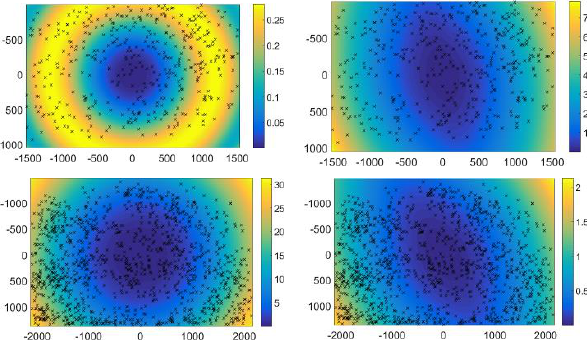
Figure 5. Magnitude of distortion results in pixel units. Left: radial distortion; Right: tangential distortion; Top: HerzJesuP8. As expected, the remaining radial distortion is low for this dataset, since the input images have been corrected for the parameters K1 and K2. Bottom: Exemplary result for a dataset with original